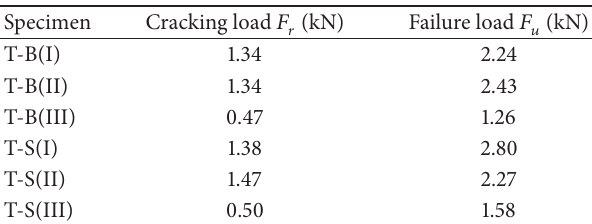
Table 2: The results of tensile tests.